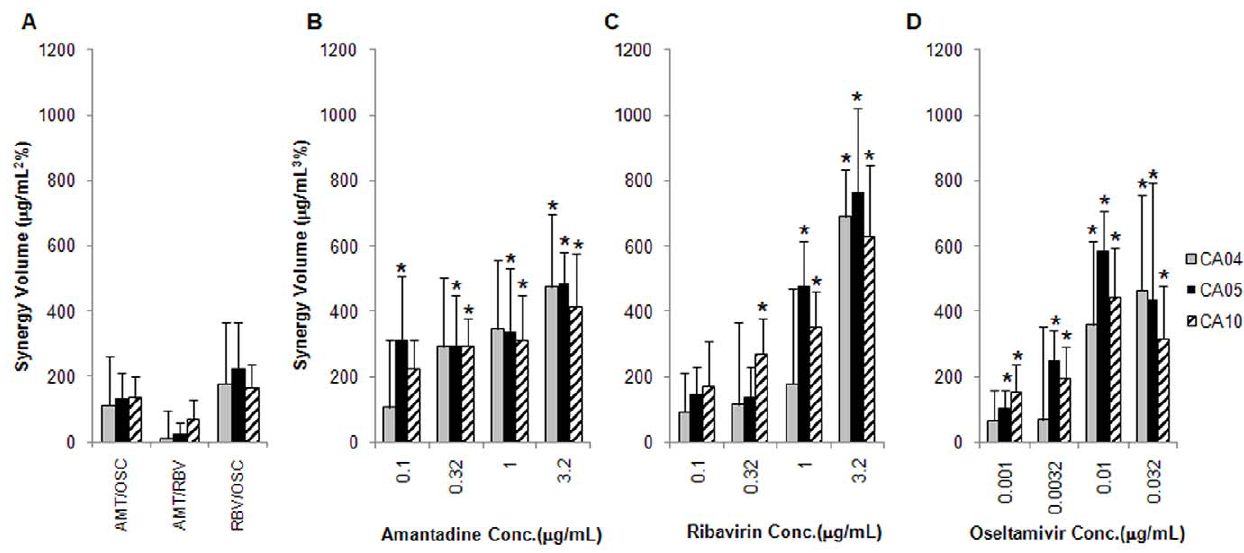
Figure 1. Synergy of double and triple combinations of amantadine, ribavirin, and oseltamivir carboxylate against 2009 H1N1. Amantadine-resistant 2009 H1N1 viruses were incubated with MDCK cells in the presence of drugs, and CPE was determined by Neutral Red assay. Synergy volumes are plotted for each double combination, and for the triple combination as a function of increasing concentration of each drug as the third drug. Gray bars, A/California/04/09 (CA04); black bars, A/California/05/09 (CA05); hatched bars, A/California/10/09 (CA10). (A) Double combinations of amantadine/oseltamivir carboxylate (AMT/OSC), amantadine/ribavirin (AMT/RBV), and ribavirin/oseltamivir carboxylate (RBV/OSC). Triple combination of amantadine, ribavirin, and oseltamivir carboxylate as a function of (B) amantadine concentration, (C) ribavirin concentration, and (D) oseltamivir carboxylate concentration. Data are presented as the mean between 18 replicates from 6 experiments with 95% confidence intervals. The concentrations of each drug used in double and triple combinations are provided in Table S1. * P , 0.05 versus double combination without drug.